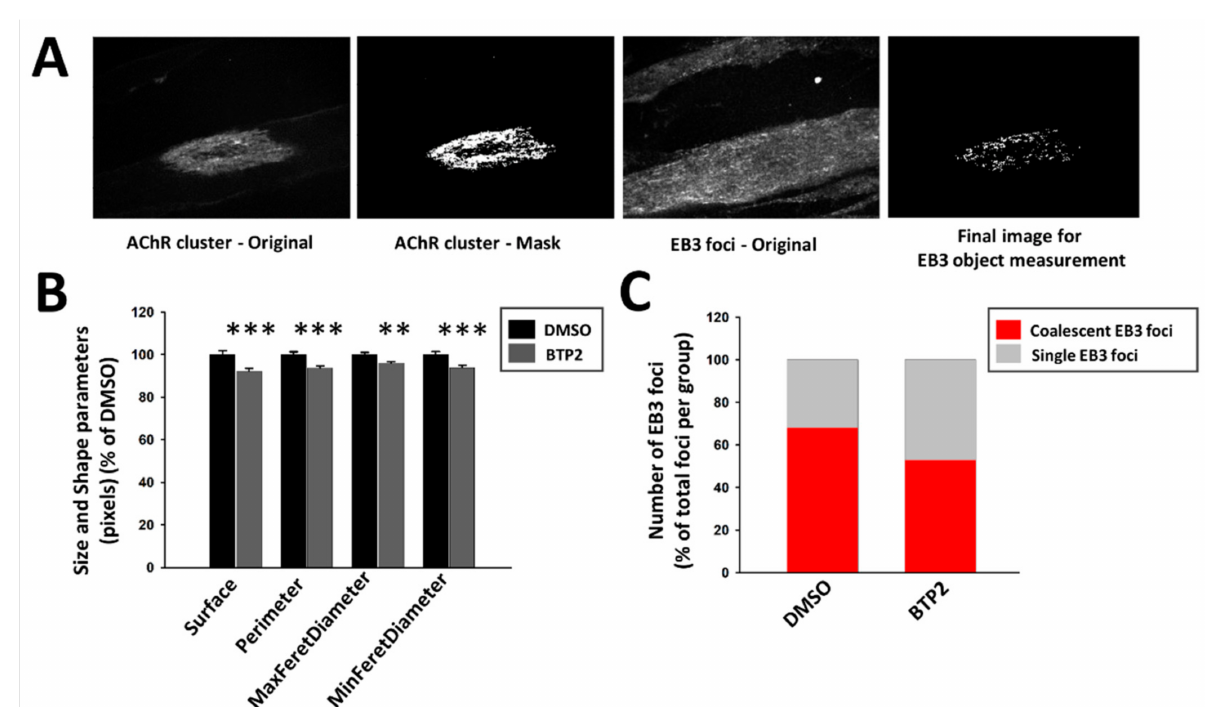
Figure 6. BTP2 impairs the organization of AChR cluster-associated mictrotubules. ( A ) Images used for processing in Ilastik and CellProfiler—segmentation and object identification. The last image on the right is an example of images used for object size and shape measurements (see Materials and Methods, Section 4.3). ( B ) Automated measurement of size and shape parameters of AChR cluster-associated EB3 foci after BTP2 treatment (CellProfiler). ( C ) Quantification of the total number of coalescent vs. single EB3 foci upon BTP2 treatment based on the surface manual measurements with ZEN software. Average surface of a single foci was used as a threshold and EB3 puncta with bigger surface were classified as coalescent. The distribution of coalescent EB3 foci is significantly different from the uniform distribution in both groups. Data are presented as a percentage of control (myotubes incubated with DMSO (vehicle)) except in ( C ), which represents a percentage of total EB3 foci analyzed in each group. Error bars represent SEM. ( B ) Student’s T -test, p ≤ 0.01 (**); p ≤ 0.001 (***); ( C ) chi-square test, p < 0.001, chi square = 681.727, 4 degrees of